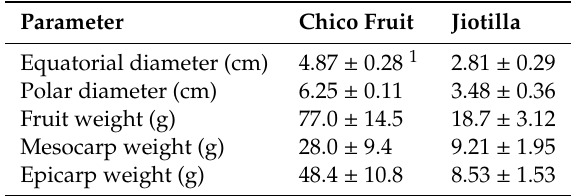
Table 1. Physical characterization of the collected plant samples.